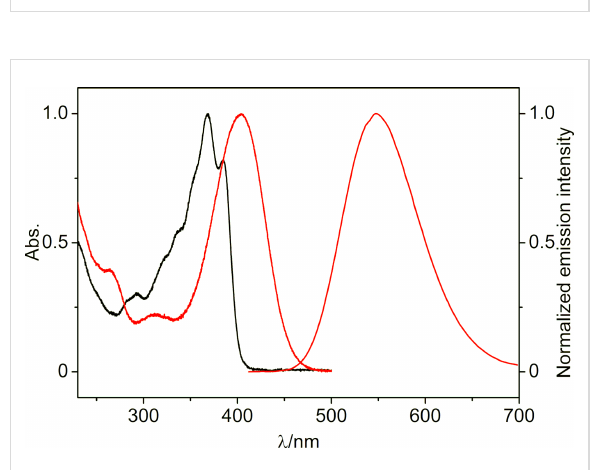
Figure 1: Absorption spectra and normalized emission spectrum (Abs. = 0.10, 3b : λ ex = 394 nm) of derivatives 3b (red) and 3d (black) in